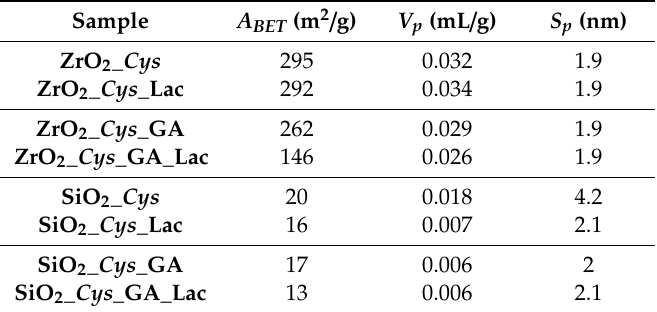
Table 4. Porous parameters of samples before and after immobilization of laccase.